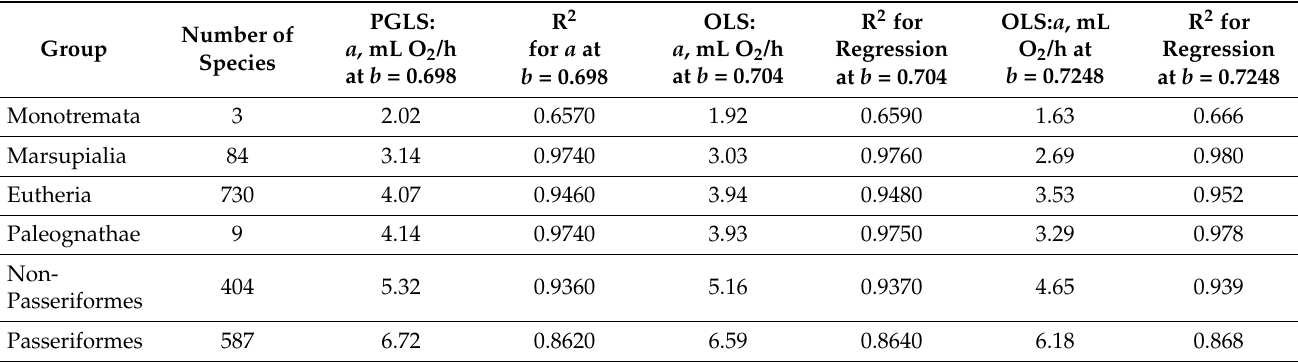
Table 2. New intercepts for at different common